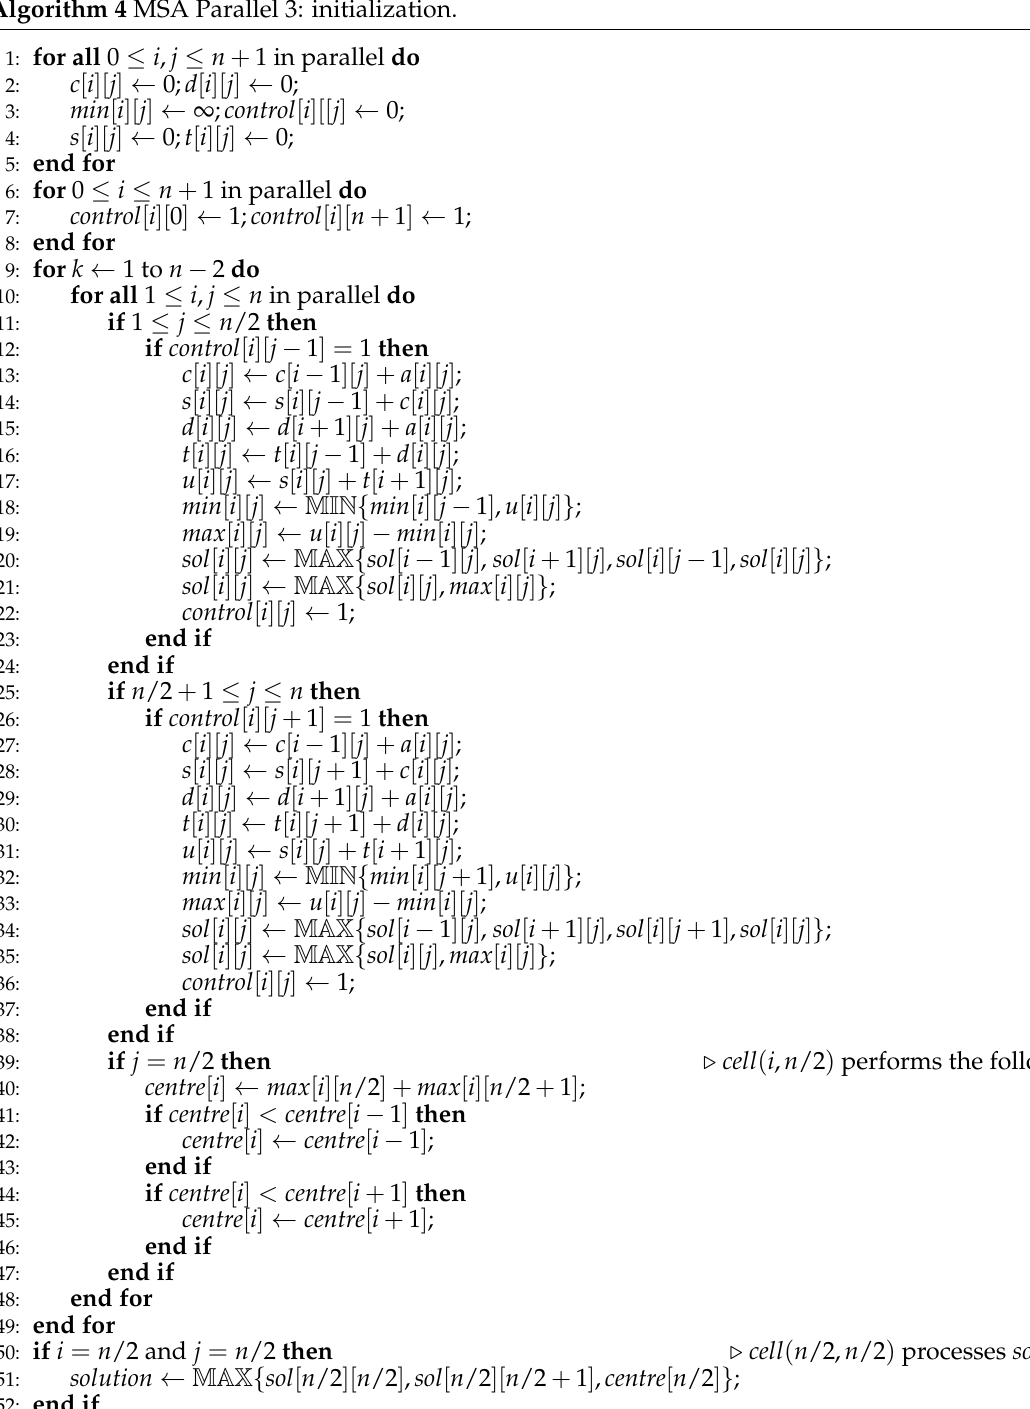
Algorithm 4 MSA Parallel 3: